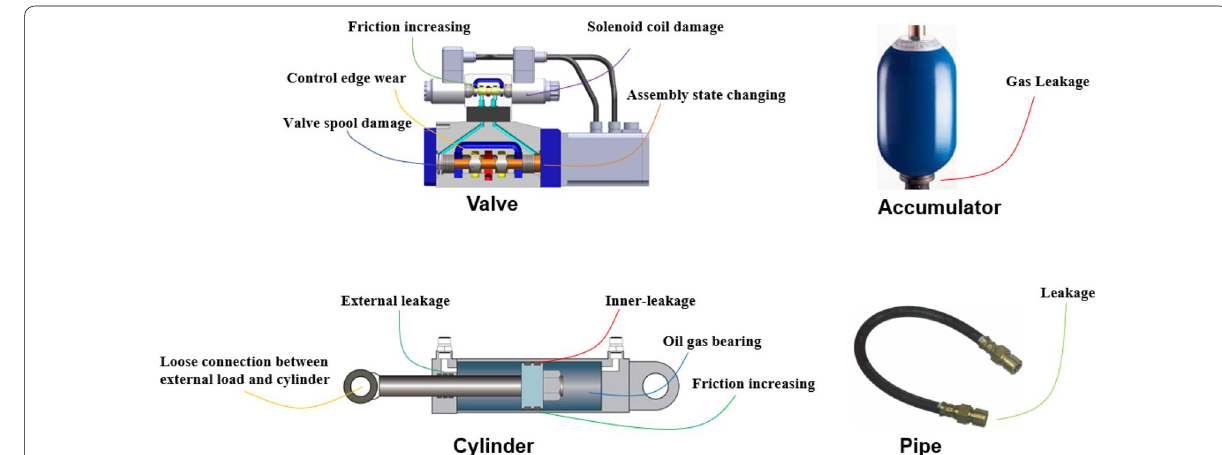
Figure 16 Valve control cylinder system faults and the corresponding components